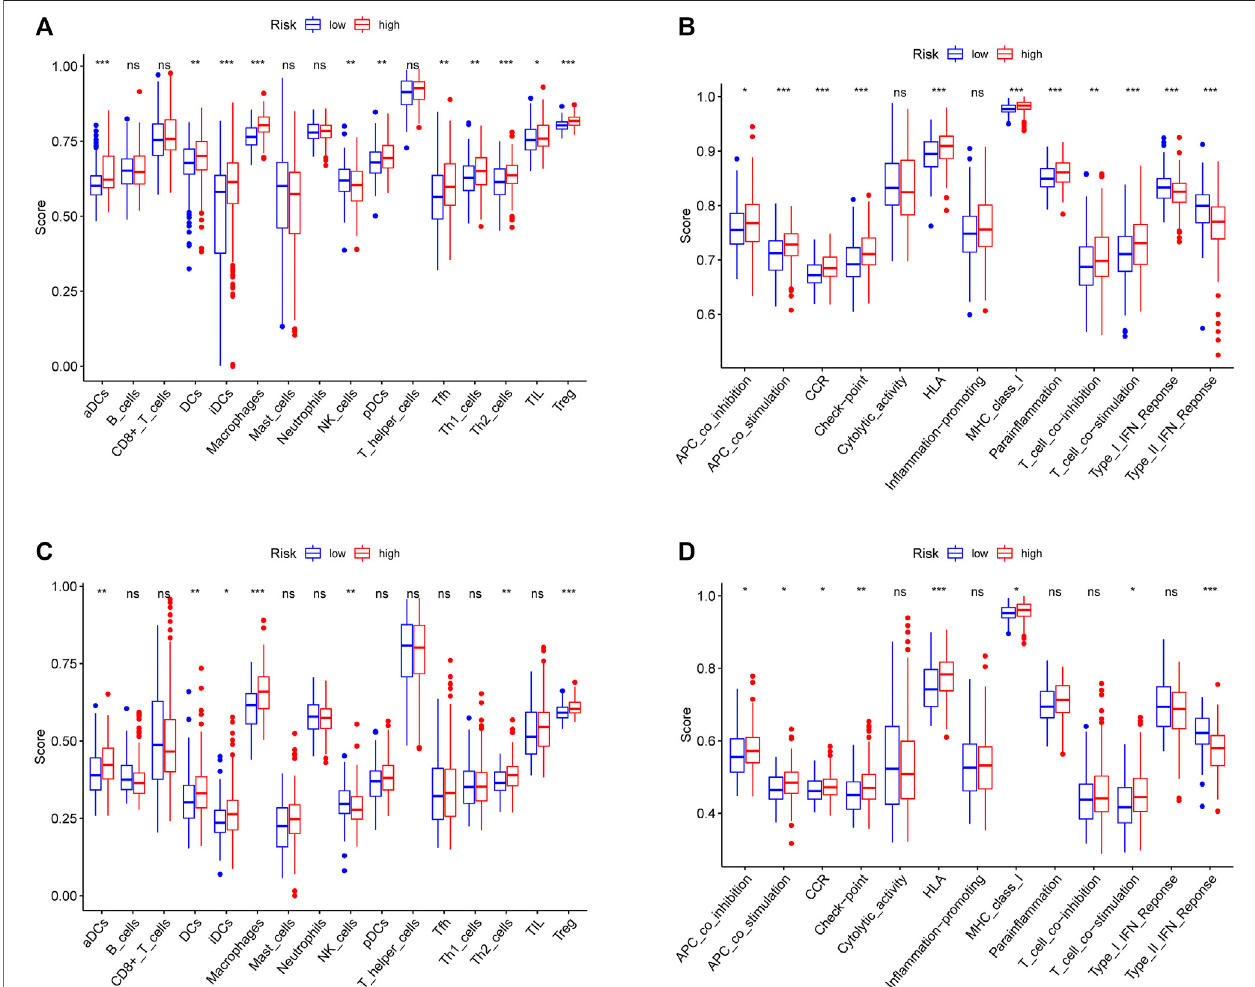
FIGURE 8 | Comparison of the immune status between the high-risk group and the low-risk group in the TCGA cohort (A, B) and ICGC cohort (C, D) . The difference of 16 immune cells (A, C) and 13 immune-related functions (B, D) is based on ssGSEA scores. * p < 0.05; ** p < 0.01; *** p < 0.001.